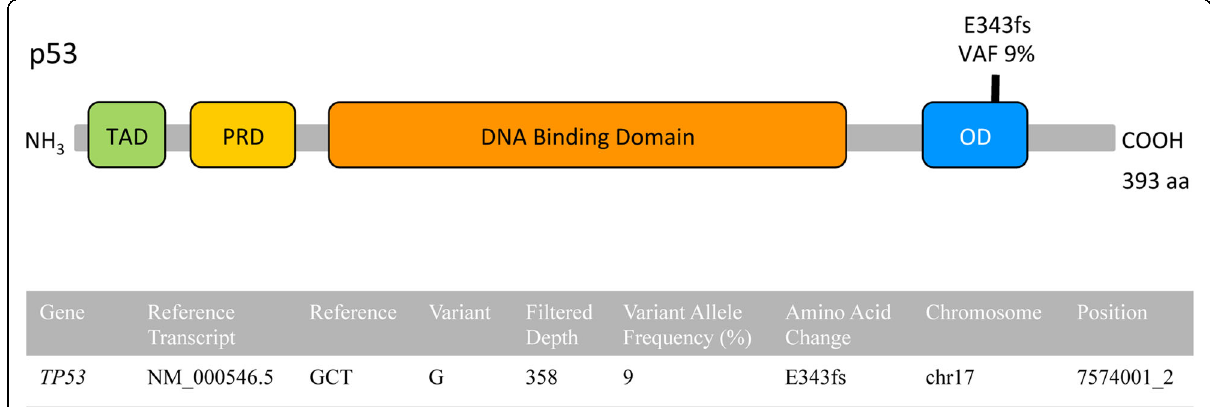
Fig. 9 Candidate pathogenic mutation in patient 2. Top: Structure of p53 protein with binding domains and frameshift mutation at position 343 located in the oligomerization domain. TAD = Transactivation domain (green), PRD = proline rich domain (yellow), OD = oligomerization domain (blue). Bottom: Candidate pathogenic mutation identified via targeted sequencing analysis of case 2 biopsy specimen by Heme-STAMP. Filtered depth = read depth of the variant